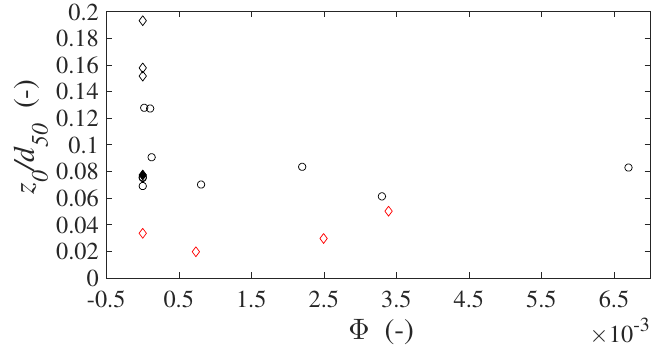
Figure 9. Variation of the roughness height normalized by the sediment diameter d , as a function of the non-dimensional bedload discharge, for scenario 3. Glass particles data are represented by red open diamonds. Data treated by Ferreira et al. [2] of type E are represented by black filled diamonds, type D by black open diamonds and type T by open